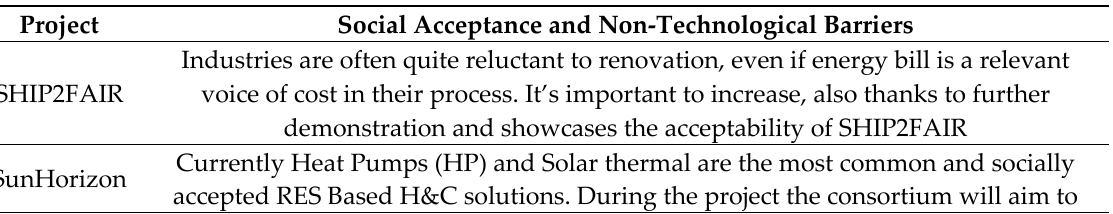
Table 3. social acceptance and non-technological